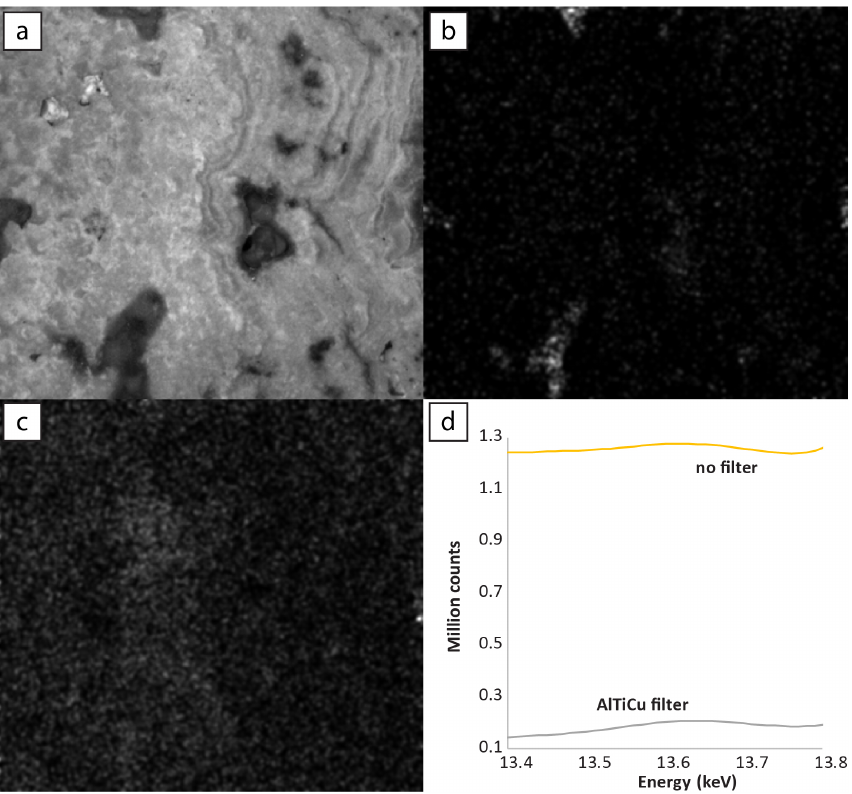
Figure 12. Comparison of U–L α maps of Barstow tufa, imaged at 25µm pixels with a 400ms per pixel dwell time and 1.5SD Gaussian blur: (a) sample image; (b) no incident radiation filter; (c) incident radiation filtered with 100µm Al, 50µm Ti, and 20µm Cu foil; (d) sum spectra of total counts in the U–L α line